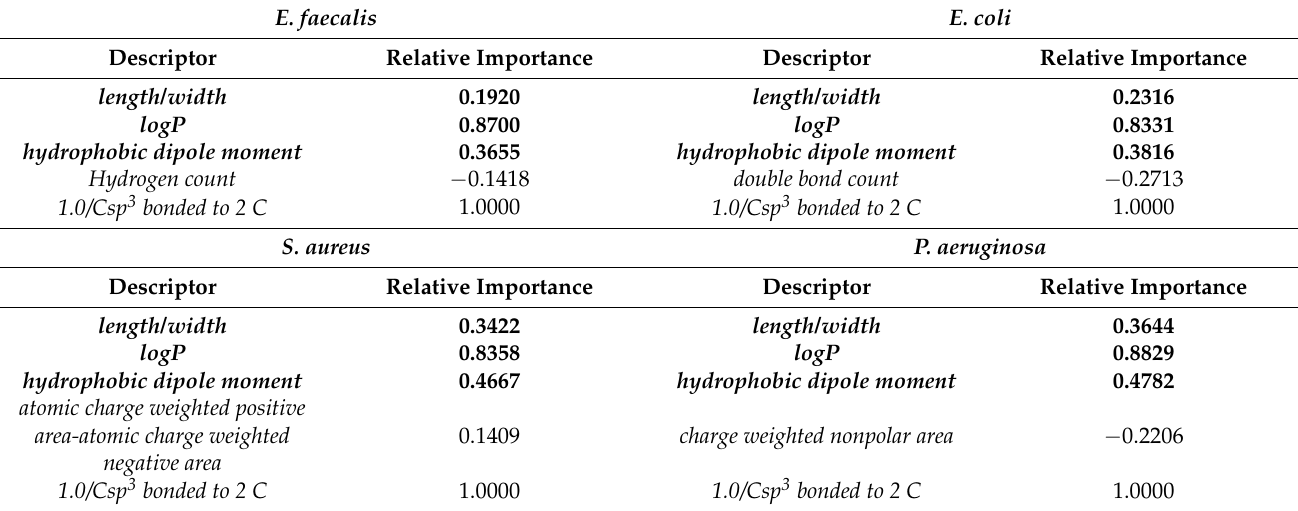
Table 1. Results from 5-Descriptor QSAR Calculations from E. faecalis , E. coli , S. aureus , and P. aeruginosa datasets with the Parameters’ Relative Importance. Frequently Appearing Descriptors were